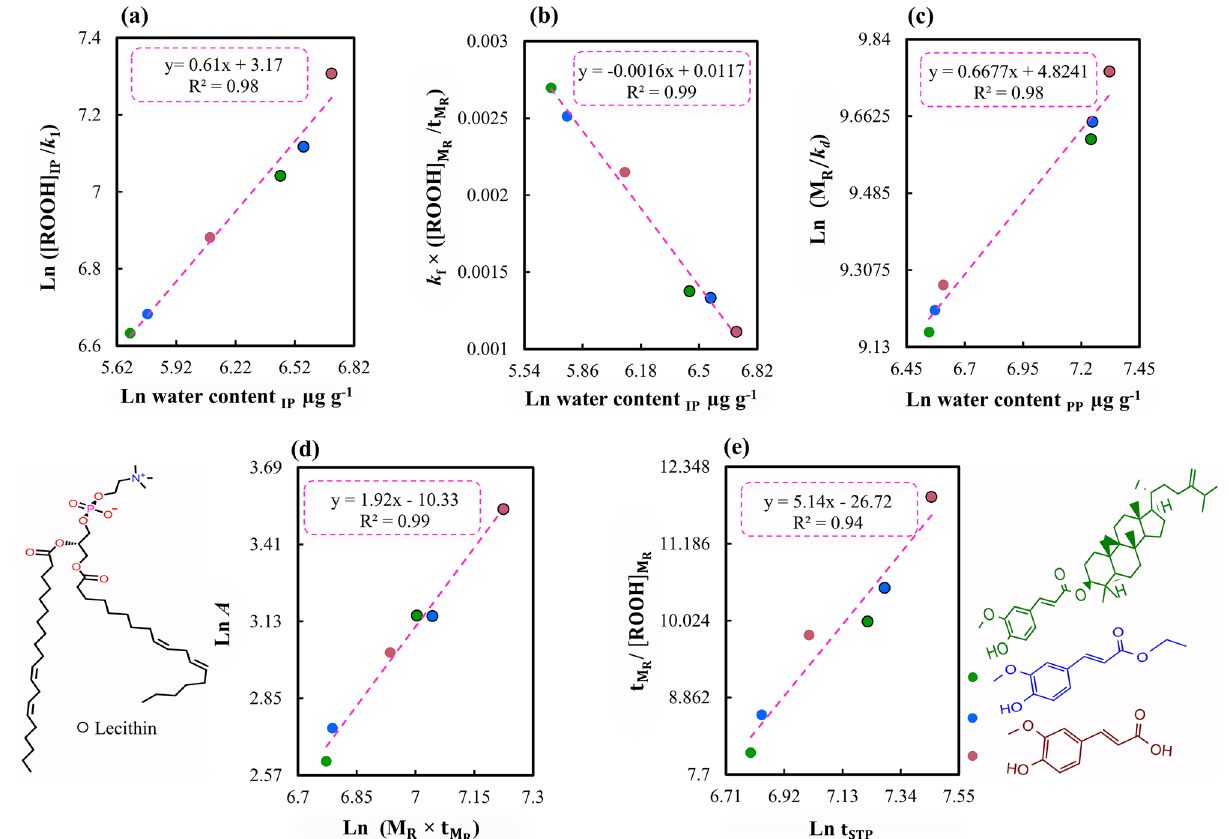
Figure 5. Relationships between various kinetic parameters in the peroxidation of stripped sunflower oil containing lecithin, ferulic acid, ethyl ferulate, γ-oryzanol and their combinations at 60 °C. A antioxidant activity, Et PP end time of the termination phase or t STP , k f rate constant of hydroperoxides (ROOHs) formation at the propagation phase, k d rate constant of ROOHs decomposition at the propagation phase, k 1 rate constant of the initiation phase, M R maximum rate of ROOHs formation in the propagation phase, [ROOH] IP ROOHs concentration at IP point, [ ROOH ] M R ROOHs concentration at the point of the maximum rate of ROOHs formation (or turning point), t M R occurrence time of the maximum rate of ROOHs formation (or turning point), water content IP water content at the IP point, water content PP water content at the PP